Question: In a single sentence, describe what this figure presents.
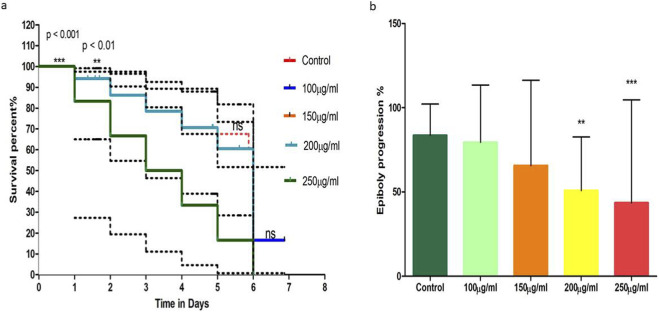
Answer: Impact of Cisp-Ge-Ne nanoemulsion system on zebrafish embryo survival and epiboly progression. (a) Kaplan–Meier survival curves of Casper zebrafish embryos exposed to increasing concentrations of Cisp-GE-NE (100, 150, 200, and 250 μg/mL) from 1 hpf to 6 dpf. The control group exhibited consistently high survival throughout the exposure period (100% ± 2.1%), confirming optimal experimental conditions. While embryos treated with 100 and 150 μg/mL showed only minor, non-significant reductions in survival (92.7% ± 3.5% and 87.2% ± 4.9%, respectively), significant dose-dependent declines were observed at higher concentrations. Survival dropped to 78.5% ± 5.8% at 200 μg/mL (p < 0.01) and further to 56.3% ± 7.2% at 250 μg/mL (p < 0.001), indicating a concentration-dependent toxicity of Cisp-GE-NE at doses ≥200 μg/mL. Survival analysis was performed using Kaplan-Meier curves and compared using the log-rank test. (b) Quantification of epiboly progression (%) at 8 hpf following 6-h exposure to Cisp-GE-NE. Embryos in the control group demonstrated normal epiboly movement (82.8% ± 4.6%), while those exposed to 100 and 150 μg/mL displayed slight, non-significant reductions (79.2% ± 5.3% and 67.8% ± 6.0%, respectively; p > 0.05). In contrast, embryos treated with 200 and 250 μg/mL exhibited significantly impaired epiboly progression (57.5% ± 7.6% and 48.5% ± 9.2%, respectively), with statistical significance indicated as p < 0.01 and p < 0.001. Data represent mean ± SEM from biological triplicates. Statistical analysis was performed using Kaplan-Meier curves and compared using the log-rank test.